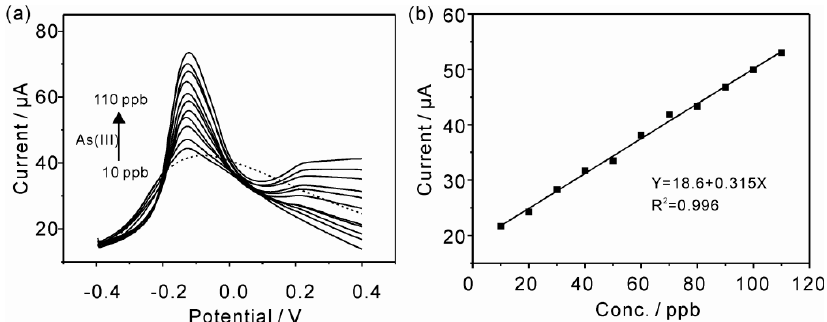
Figure 4. SWASV responses ( a ) and the corresponding calibration plot ( b ) of the MnFe 2 O 4 /Au hybrid nanospheres modified GCE toward As(III) over a concentration range of 10 to 110 ppb by depositing for 150 s in 0.1 M HAc-NaAc (pH 5.0). Deposition potential: − 0.9V, step potential: 4 mV, amplitude: 25 mV, and frequency: 25 Hz. Table 1. Comparison of current sensitivity with previously reported values of different electrodes for electrochemical detection of As(III).